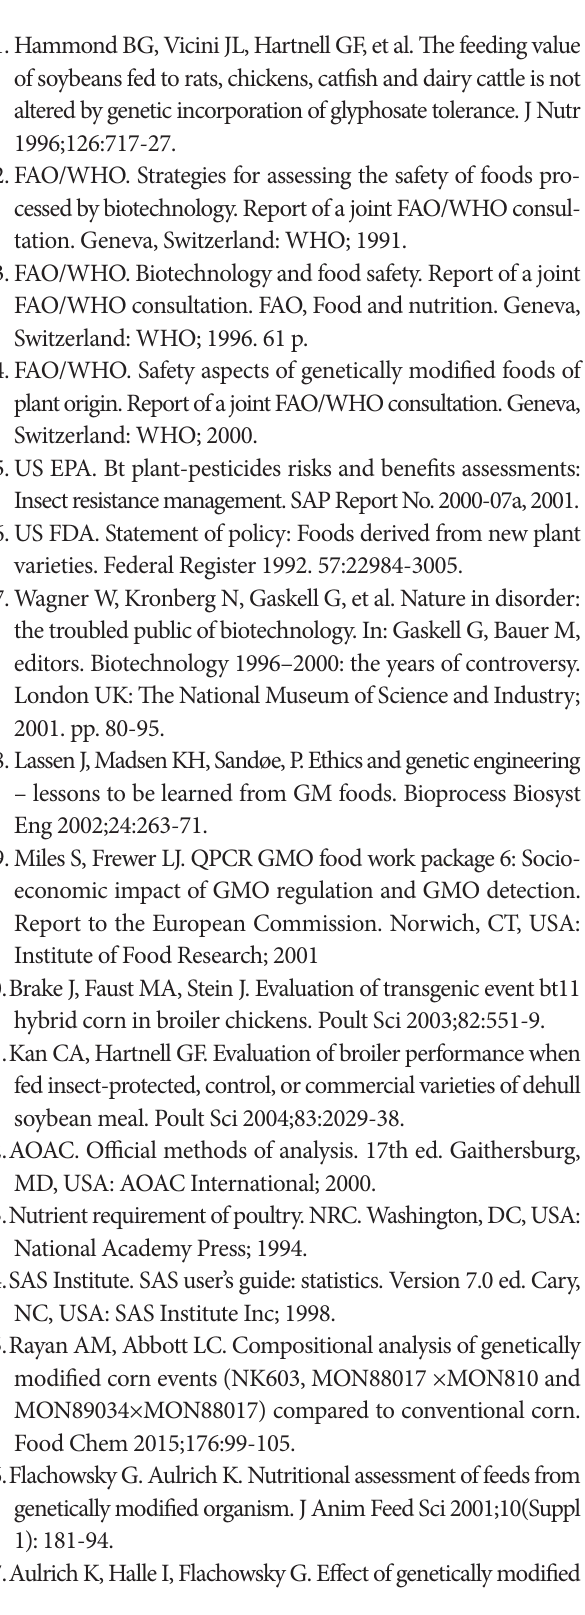
Table 8. Effect of GMO and non-GMO corn-SBM diets on meat quality and organ weigh of broilers Items TRT1 1) TRT2 1)